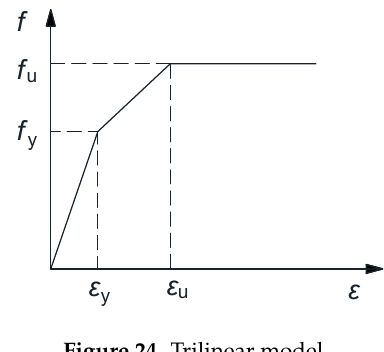
Figure 24. Trilinear model.